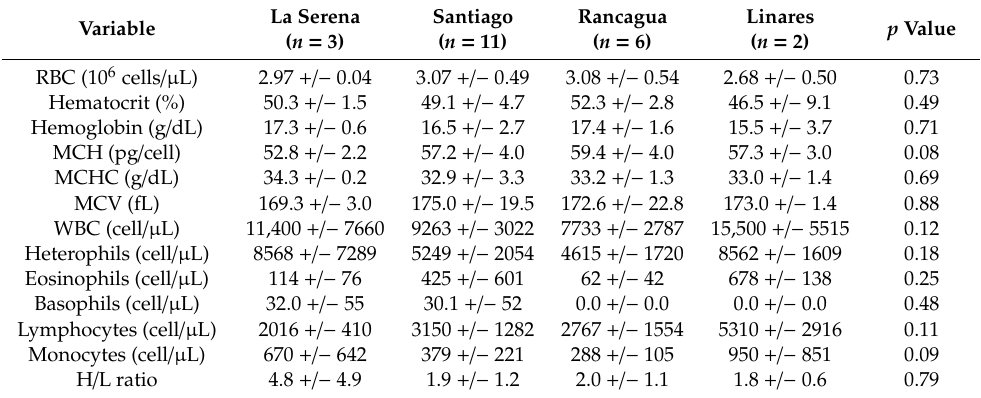
Mean ± standard deviation of hematological variables of captive black-faced ibis ( Theristicus melanopis ) according to sampling location (N = 22).